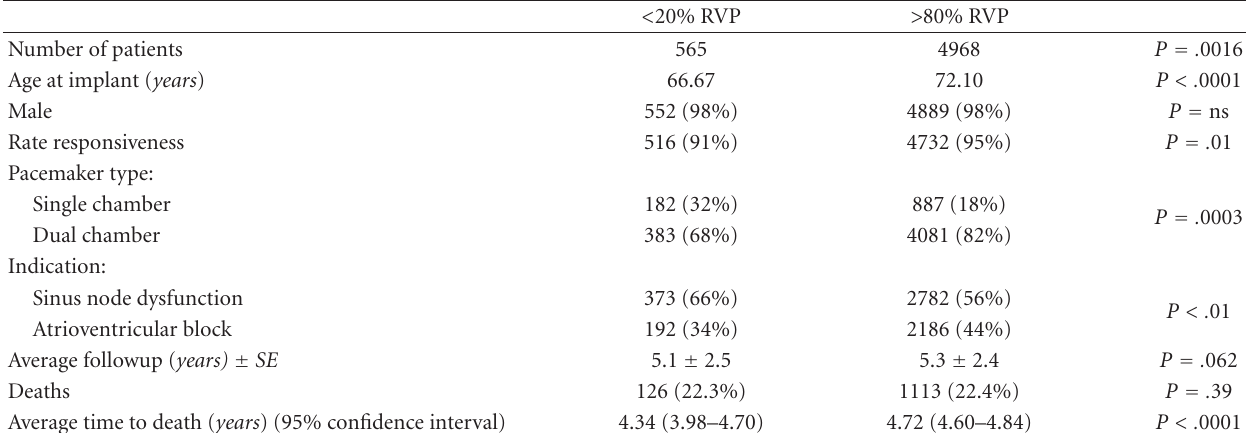
Table 2: Study findings.